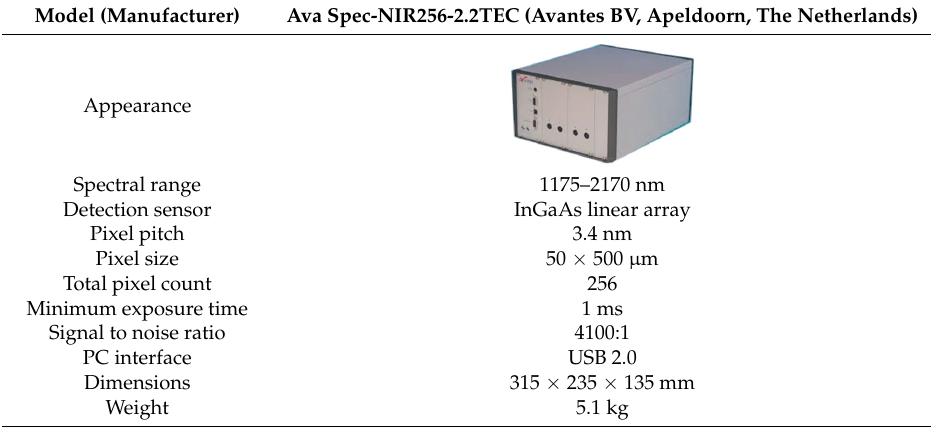
Table 3. Specifications of NIR spectrometer used for classification of Fusarium -infected hulled barley. Model (Manufacturer)